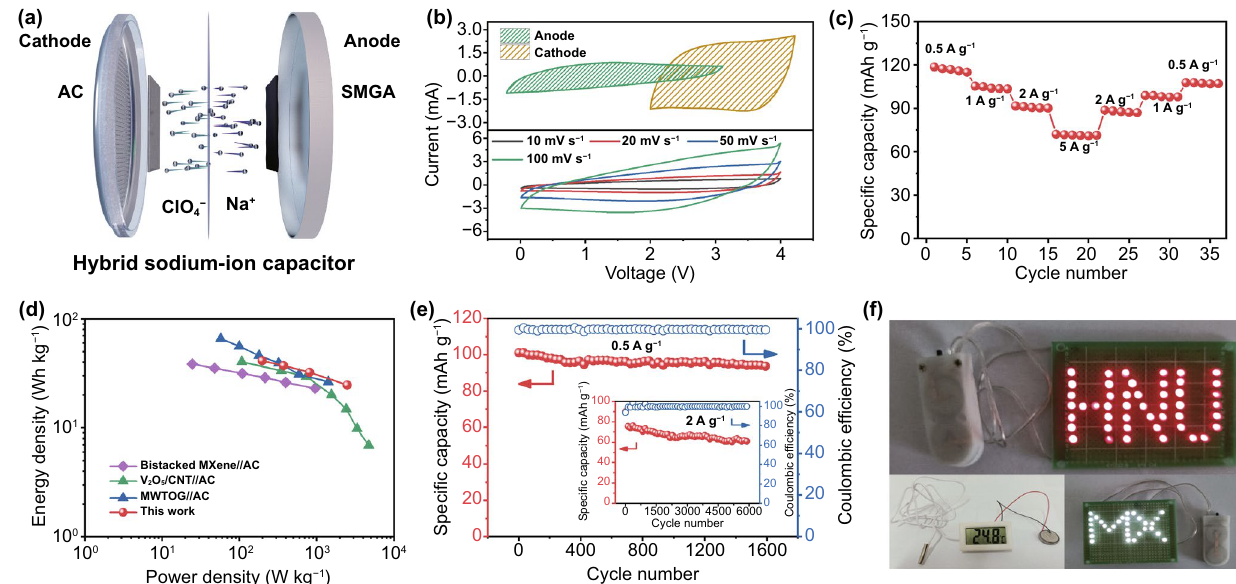
Fig. 6 a Schematics of the assembled AC//SMGA hybrid sodium-ion capacitor (SIC). b CV curves of SMGA and AC in a Na-ion half-cell at a scan rate of 10 mV s −1 (top part) and AC//SMGA SIC at different scan rates (bottom part). c Rate performances of the AC//SMGA SIC at rates ranging from 0.5 to 5 A g −1 . d Ragone plots of the AC//SMGA SIC compared to previously reported SICs: Bistacked MXene//AC [57], V 2 O 5 / CNT//AC [58], and